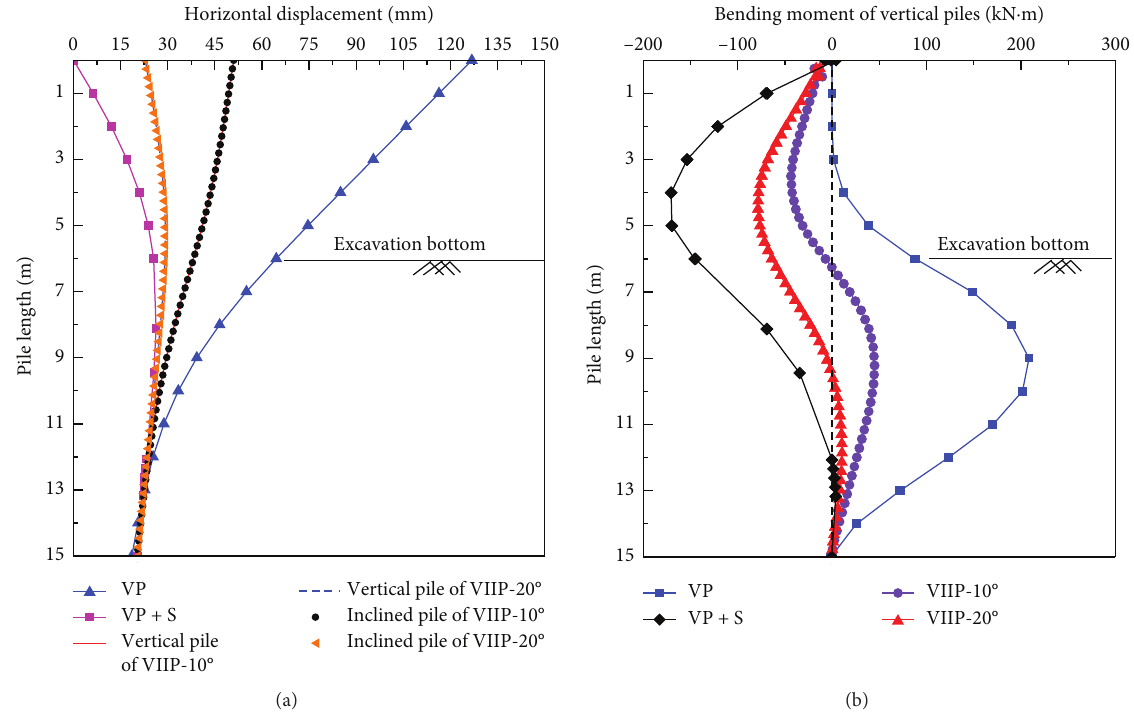
Figure 13: Comparison of horizontal displacements and bending moments of VP, VP +S, and VIIP. (a) Horizontal displacements. (b) Bending moments.